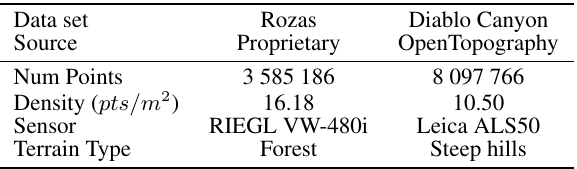
Table 2. Technical data of the data sets used in the evaluation.